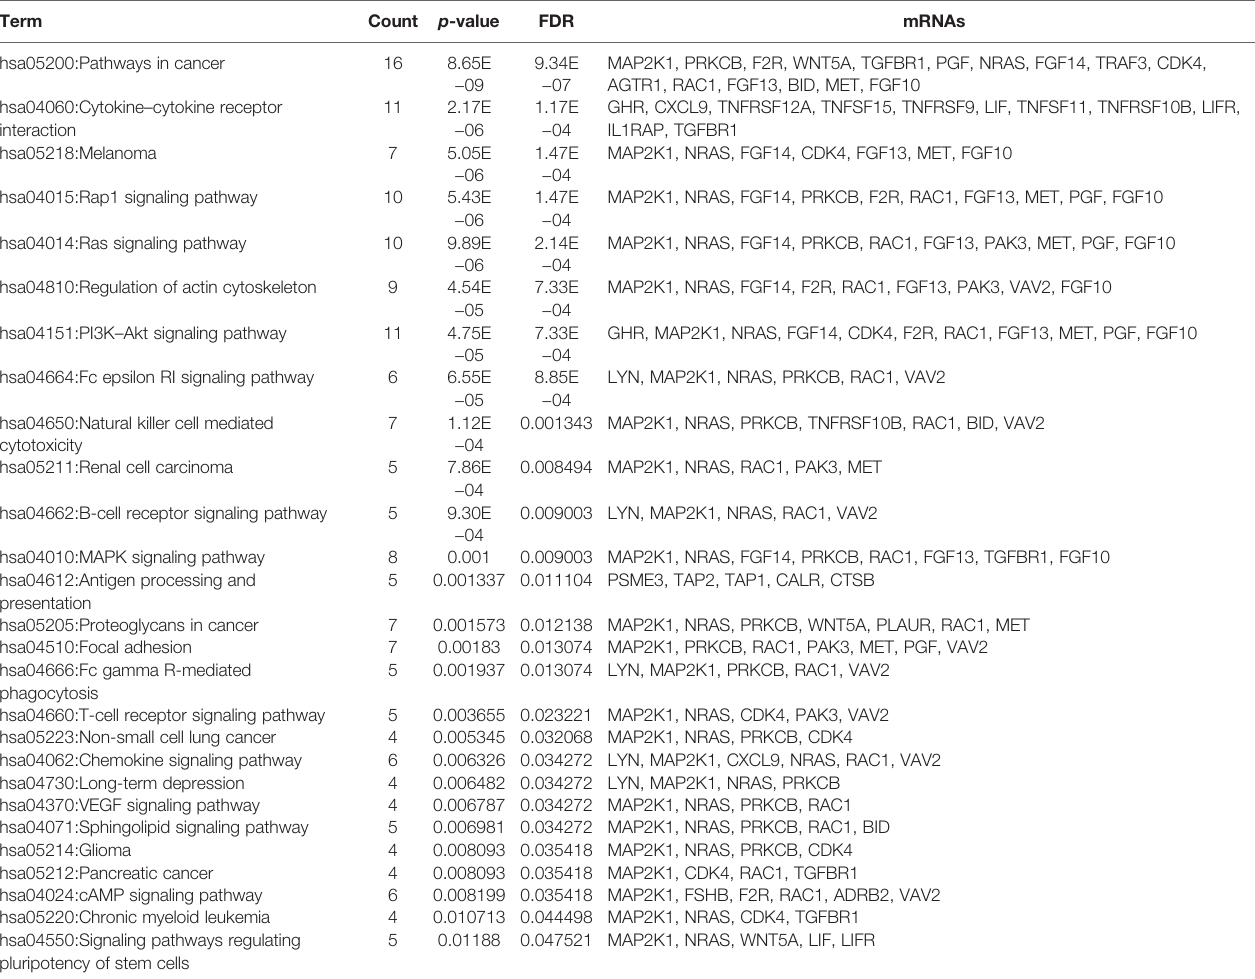
TABLE 5 | KEGG enrichment analysis of immune-related mRNAs in the ceRNA regulatory network in